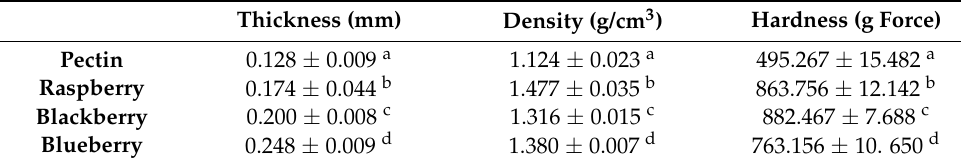
Table 2. Thickness, density, and hardness of the developed